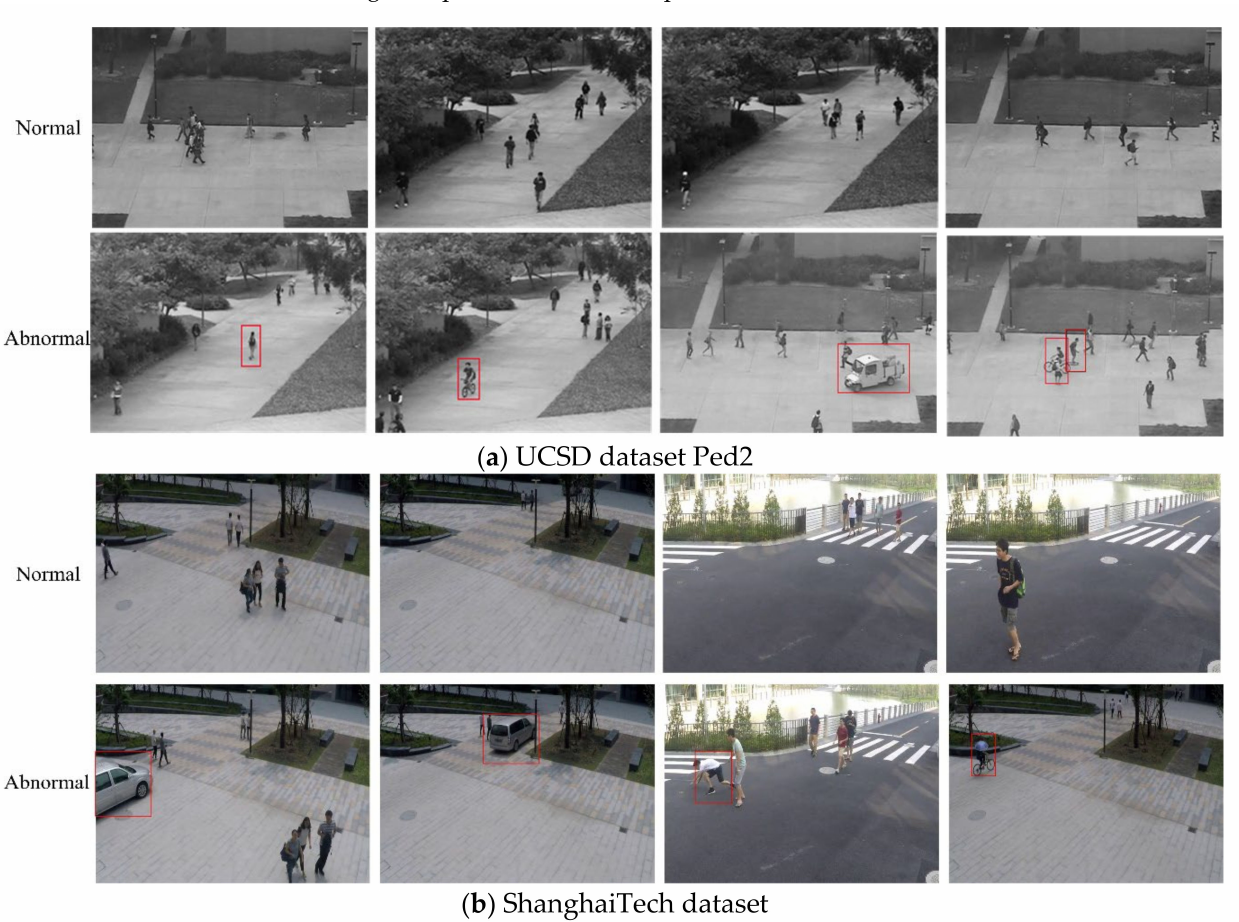
Figure 5. This is a figure. Schemes follow the same